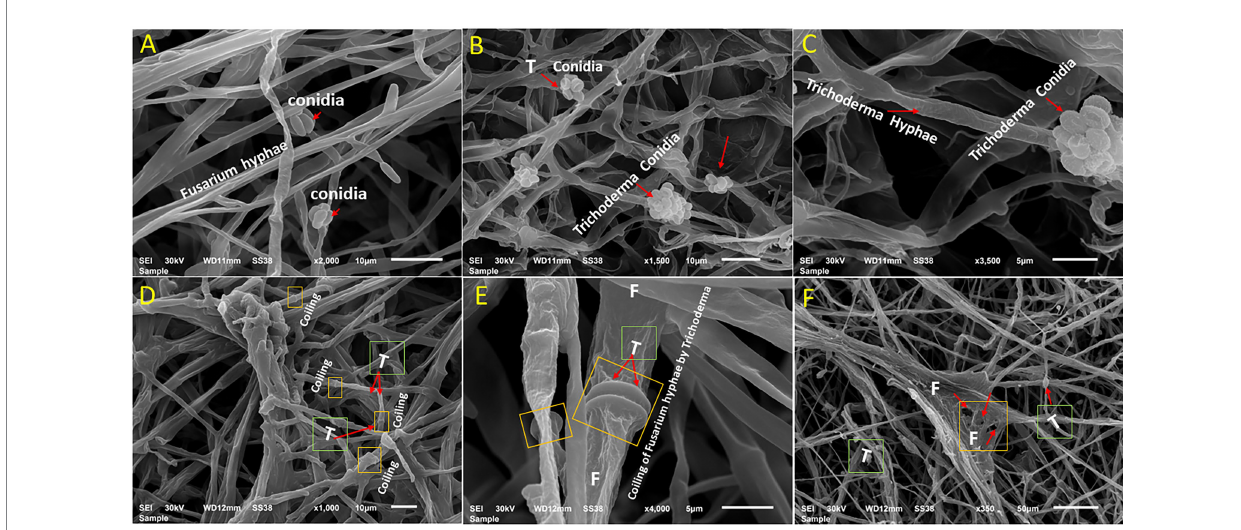
FIGURE 3 Scanning electron microscopy interpretations of the mycoparasitic of T. asperellum on F. oxysporum . (A) Fusarium pathogen alone, (B,C) T. asperellum alone (endophytic hyphae and conidia), (D) Mycelium of both fungi in contact via growing of Trichoderma hyphae (T) over Fusarium hyphae, (E) Coiling of Fusarium hyphae (F) by Trichoderma (T) as one of the antagonistic mechanisms (arrows), (F) Deformation of F. oxysporum by T. asperellum.